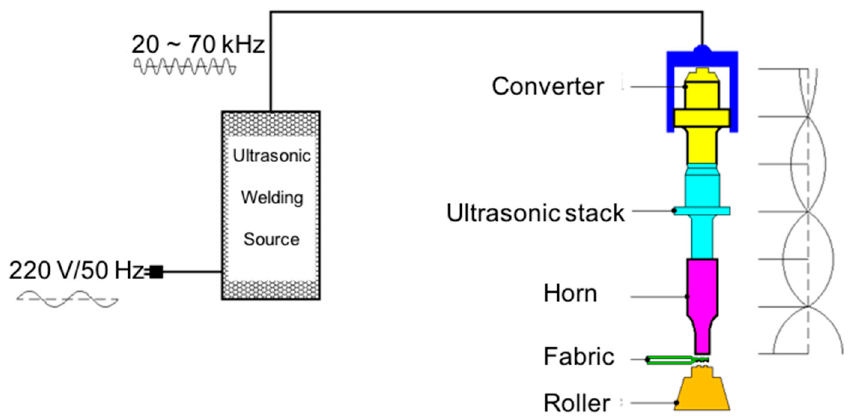
Figure 1. A schematic diagram of a common ultrasonic welding equipment.